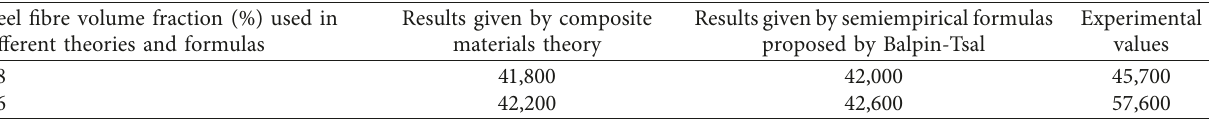
Table 6: Comparison of the elastic moduli of directionally distributed SFRC (unit: MPa). Steel fibre volume fraction (%) used